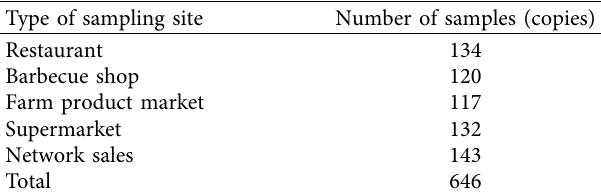
Table 2: Sample collection